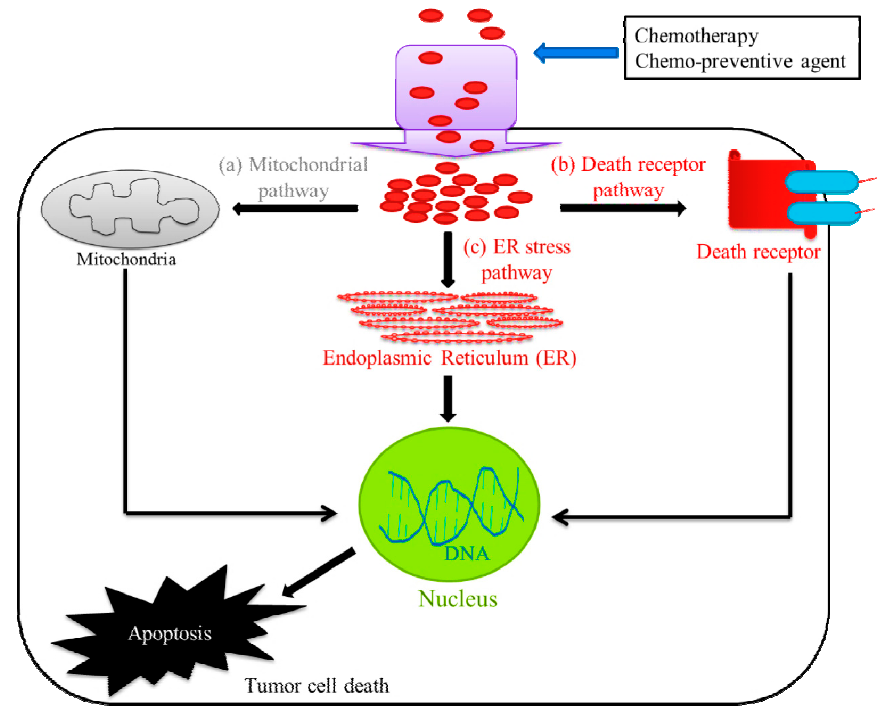
Figure 1. Pathways involved in tumor cell death. The chemotherapeutic treatment or chemotherapy mainly utilize three different pathways that lead to tumor cell death or apoptosis, which are (a) the extrinsic death receptor pathway, (b) the intrinsic mitochondrial pathway, and (c) the endoplasmic reticulum stress (ERS)